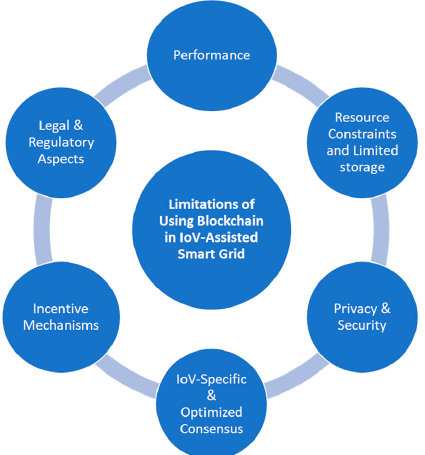
Figure 12. Limitations of using blockchain in IoV-assisted smart grids.